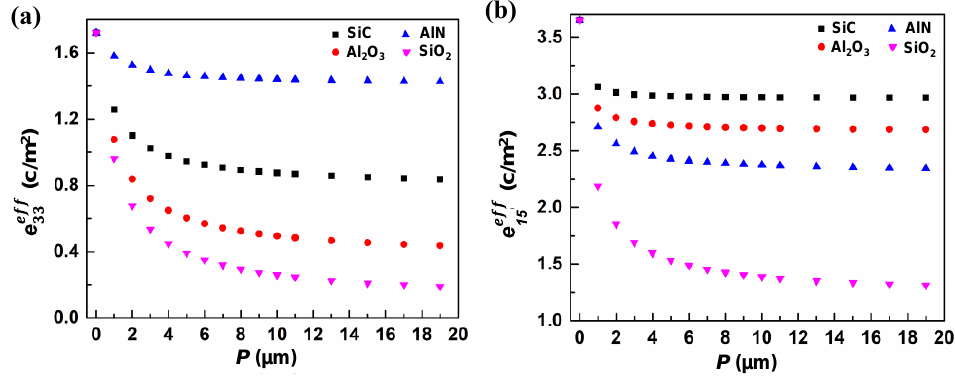
Figure 2. Effective piezoelectric coefficients 𝑒 33𝑒𝑓𝑓 ( a ) and 𝑒 15𝑒𝑓𝑓 ( b ) of four different LiNbO 3 -based composite materials as function of the width of nonpiezoelectric materials ( P ).